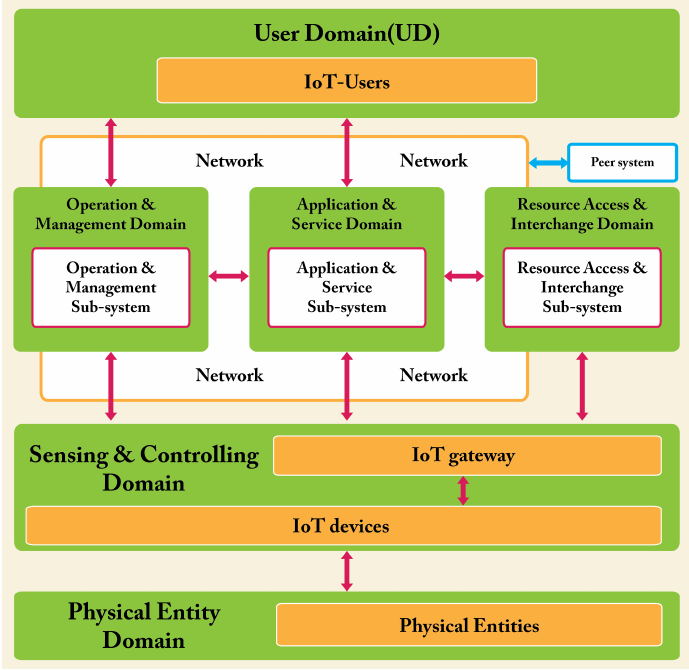
Figure 8. Entity-based RM vs. domain-based